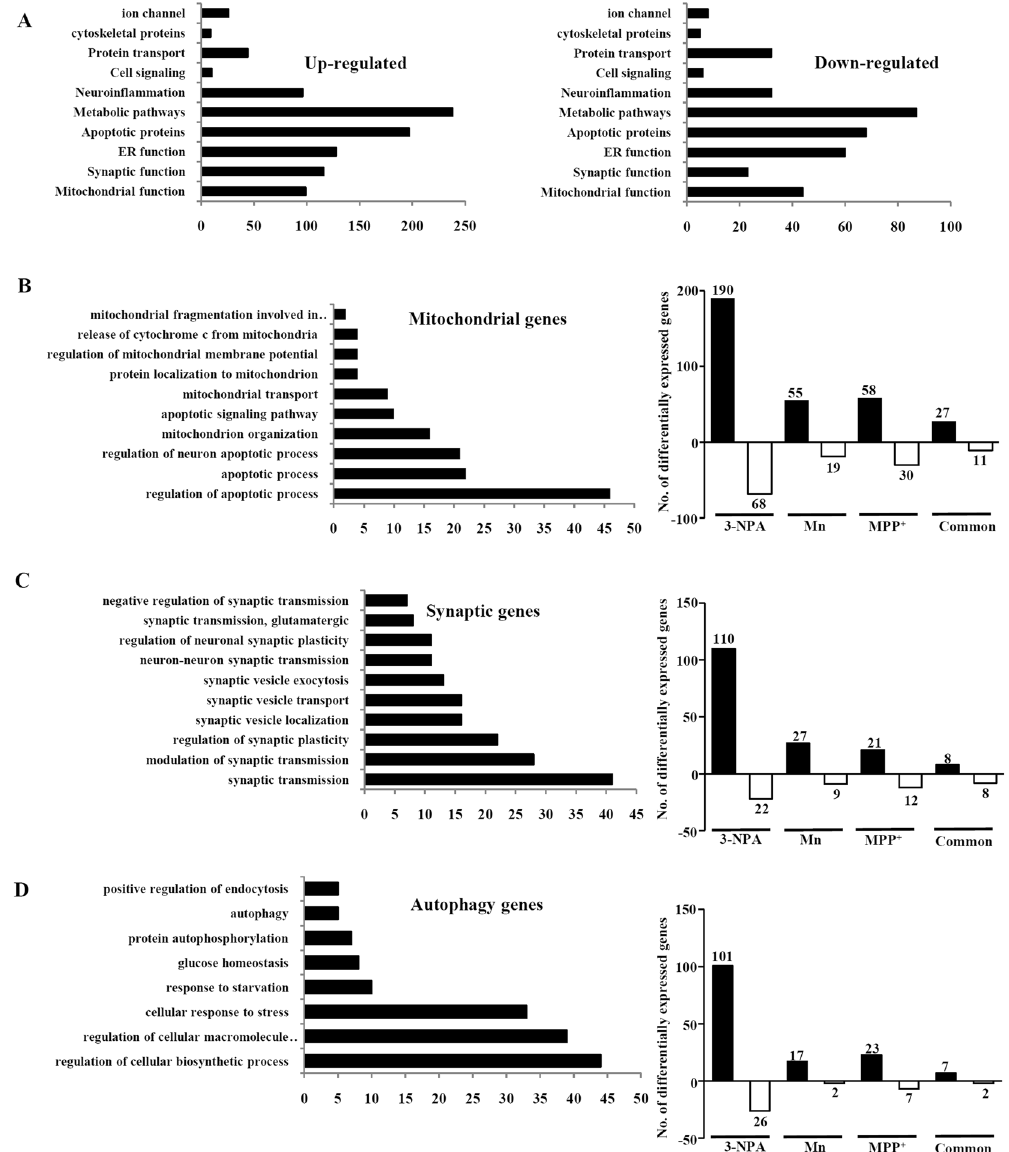
Figure 2. Functional classification and GO analysis of the differentially regulated genes upon Mn/MPP + /3-NPA treatment. ( A ) Functional classification of all the up- and down-regulated genes in the 3-NPA model. Functional classification and the number of differentially regulated genes among three major pathways—mitochondrial ( B ), synaptic ( C ) and autophagic ( D ) are